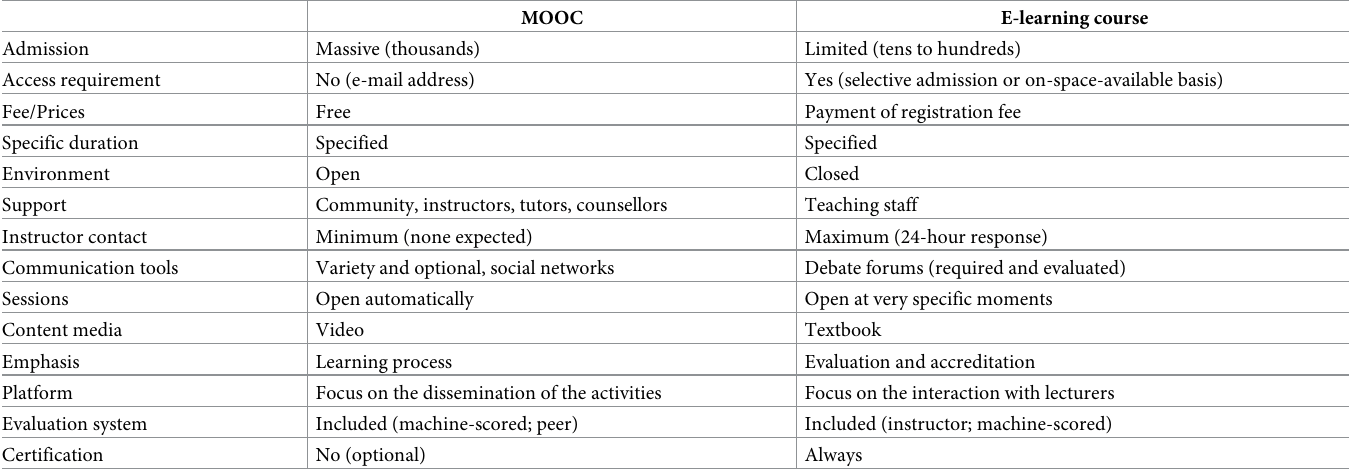
Table 1. Characteristics of MOOCs and e-learning